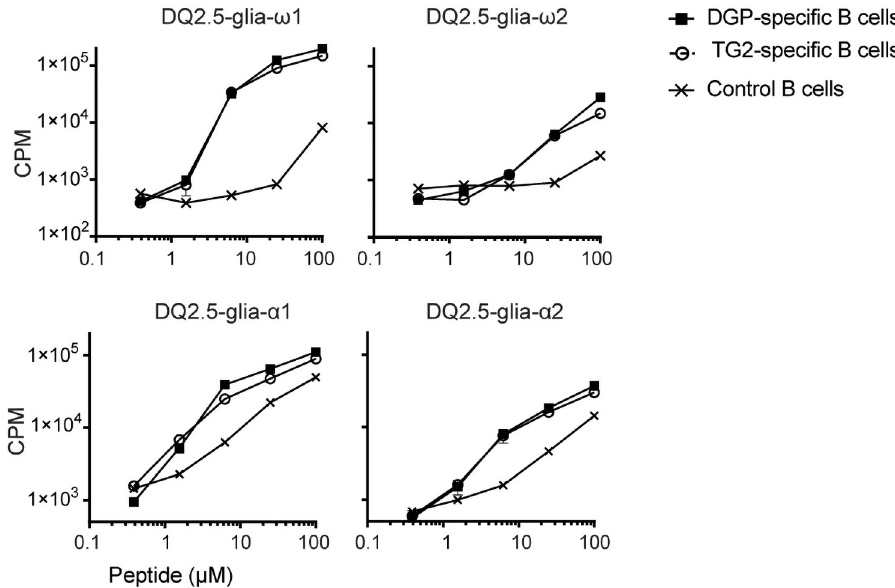
Fig 6. Activation of gluten-specific T cells following pulsing of A20 B cells with active TG2 and native gluten peptides. (A) Irradiated A20 cells expressing HLA-DQ2.5 and a TG2-specific BCR (14E06), gluten-specific BCR (3B01) or non-specific BCR (2F02) were incubated with different concentrations of native ω 34mer or native α 33mer gliadin peptide in the presence of 50 nM TG2 and 2 mM CaCl 2 for 5 min at 37˚C, then washed and cultured at 37˚C. The next day, gluten-specific TCC specific for the DQ2.5-glia- ω 1 (TCC1383.P.A.6), DQ2.5-glia- ω 2 (TCC737.30), DQ2.5-glia- α 1 epitope (TCC387.9) or DQ2.5-glia- α 2 epitope (TCC436.5.3) were added. T-cell proliferation was assessed after 72h by [ 3 H] thymidine incorporation. Symbols represent mean counts per minute (CPM) +/- SEM of culture duplicates and are representative of 2–3 independent experiments.